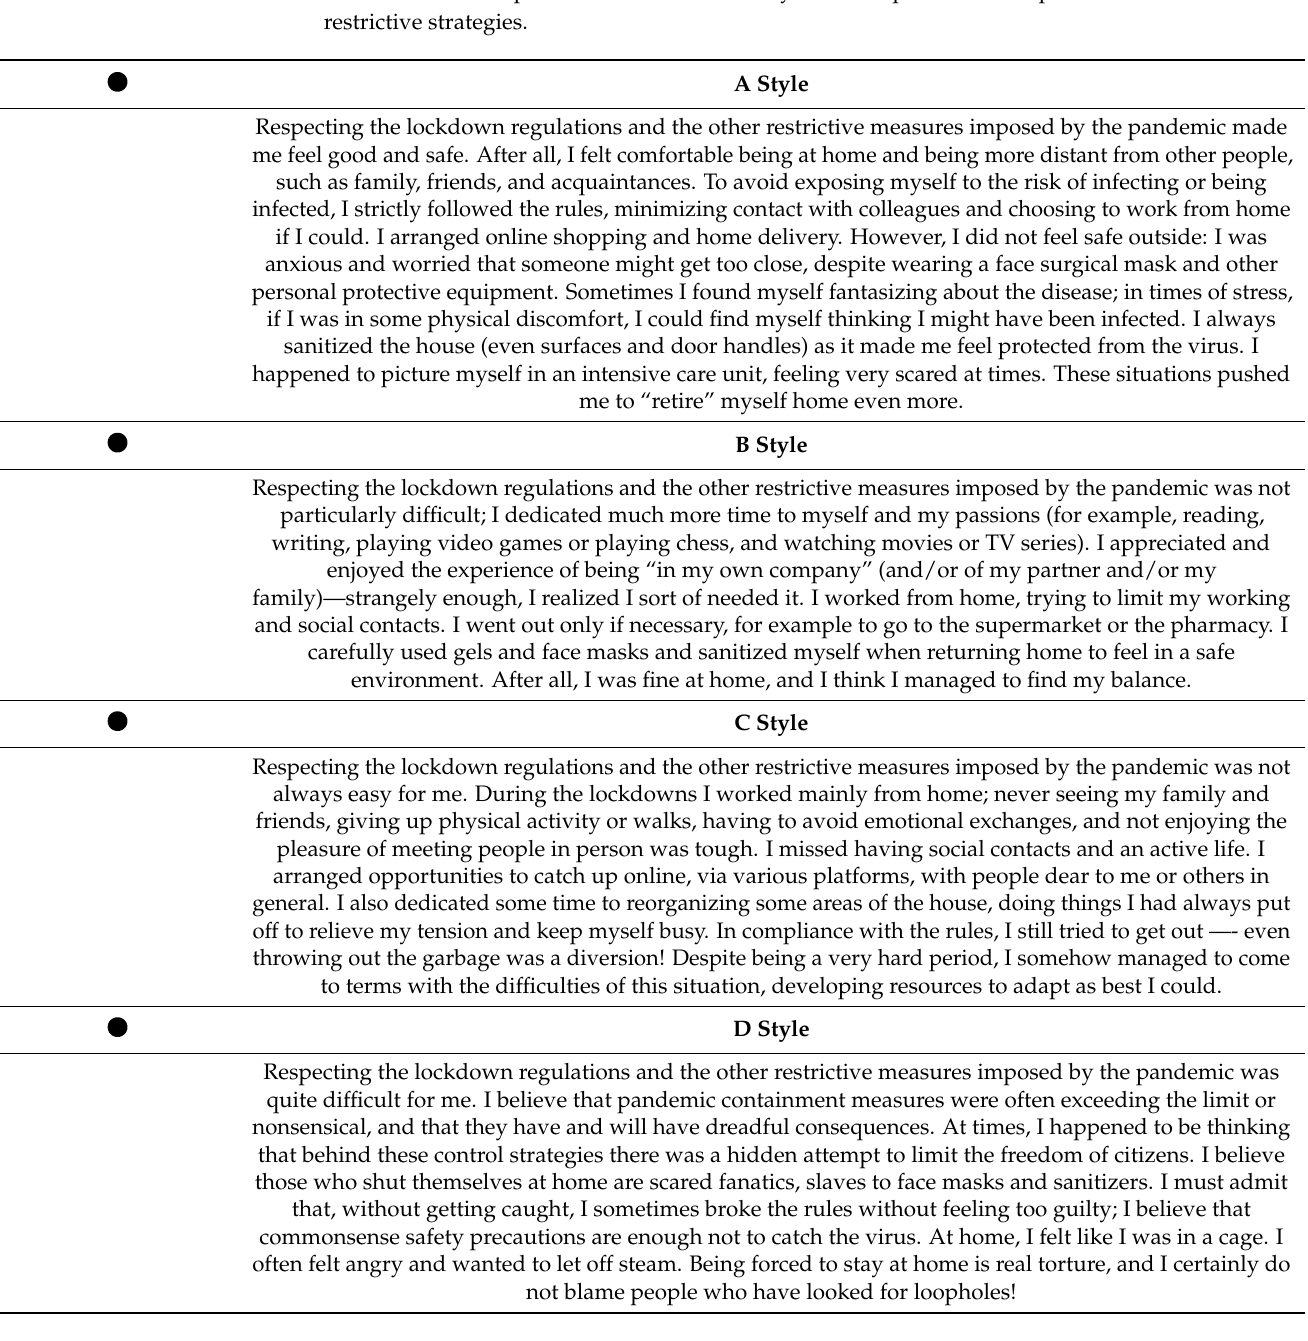
Table A1. Description of four different styles of response to the pandemic and its related restrictive strategies.